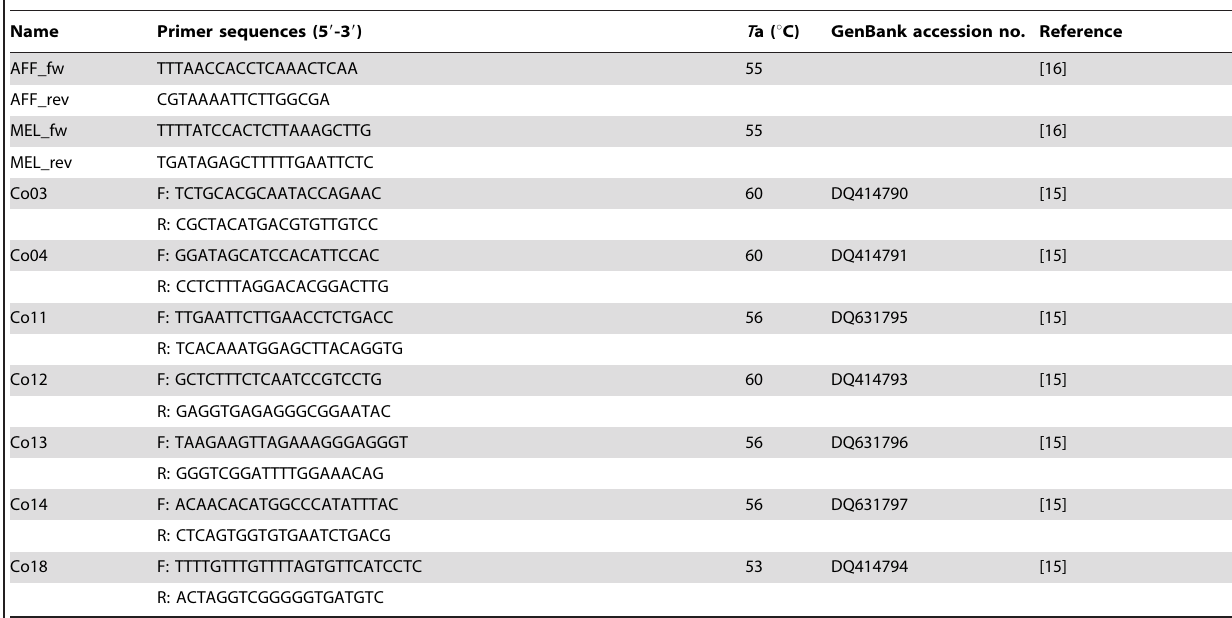
Table 2. Summary data for the microsatellites developed from Cacopsylla melanoneura.